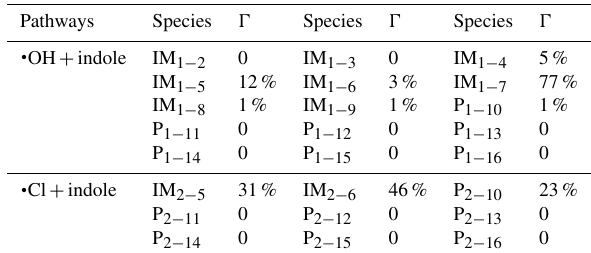
Table 1. Calculated branching ratios ( (cid:48) ) for the indole reactions at 298K and